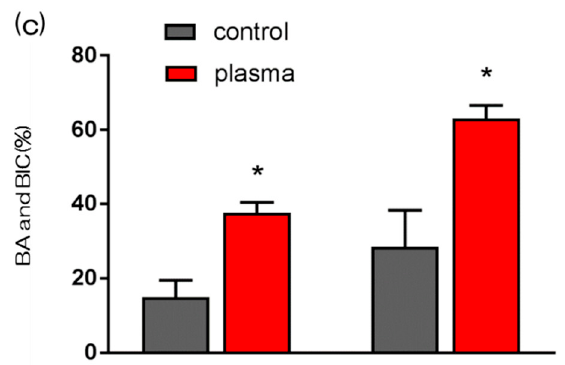
Figure 6. The histological sections showed that control implants still exhibited fibrous connective tissue from the bone-implant interface, whereas the test implants were almost entirely surrounded with new bone ( a ; control, b ; test). The part indicated by the red arrow is the new-formed bone. In both ( a , b ), new bone formation was observed around the implant model, but in ( b ), more new bone formation was observed. ( c ) Furthermore, histomorphometric analysis showed that bone area ratio (BA) and bone-to-implant contact (BIC) were significantly higher around the test implants than around the control implants (* p < 0.05).